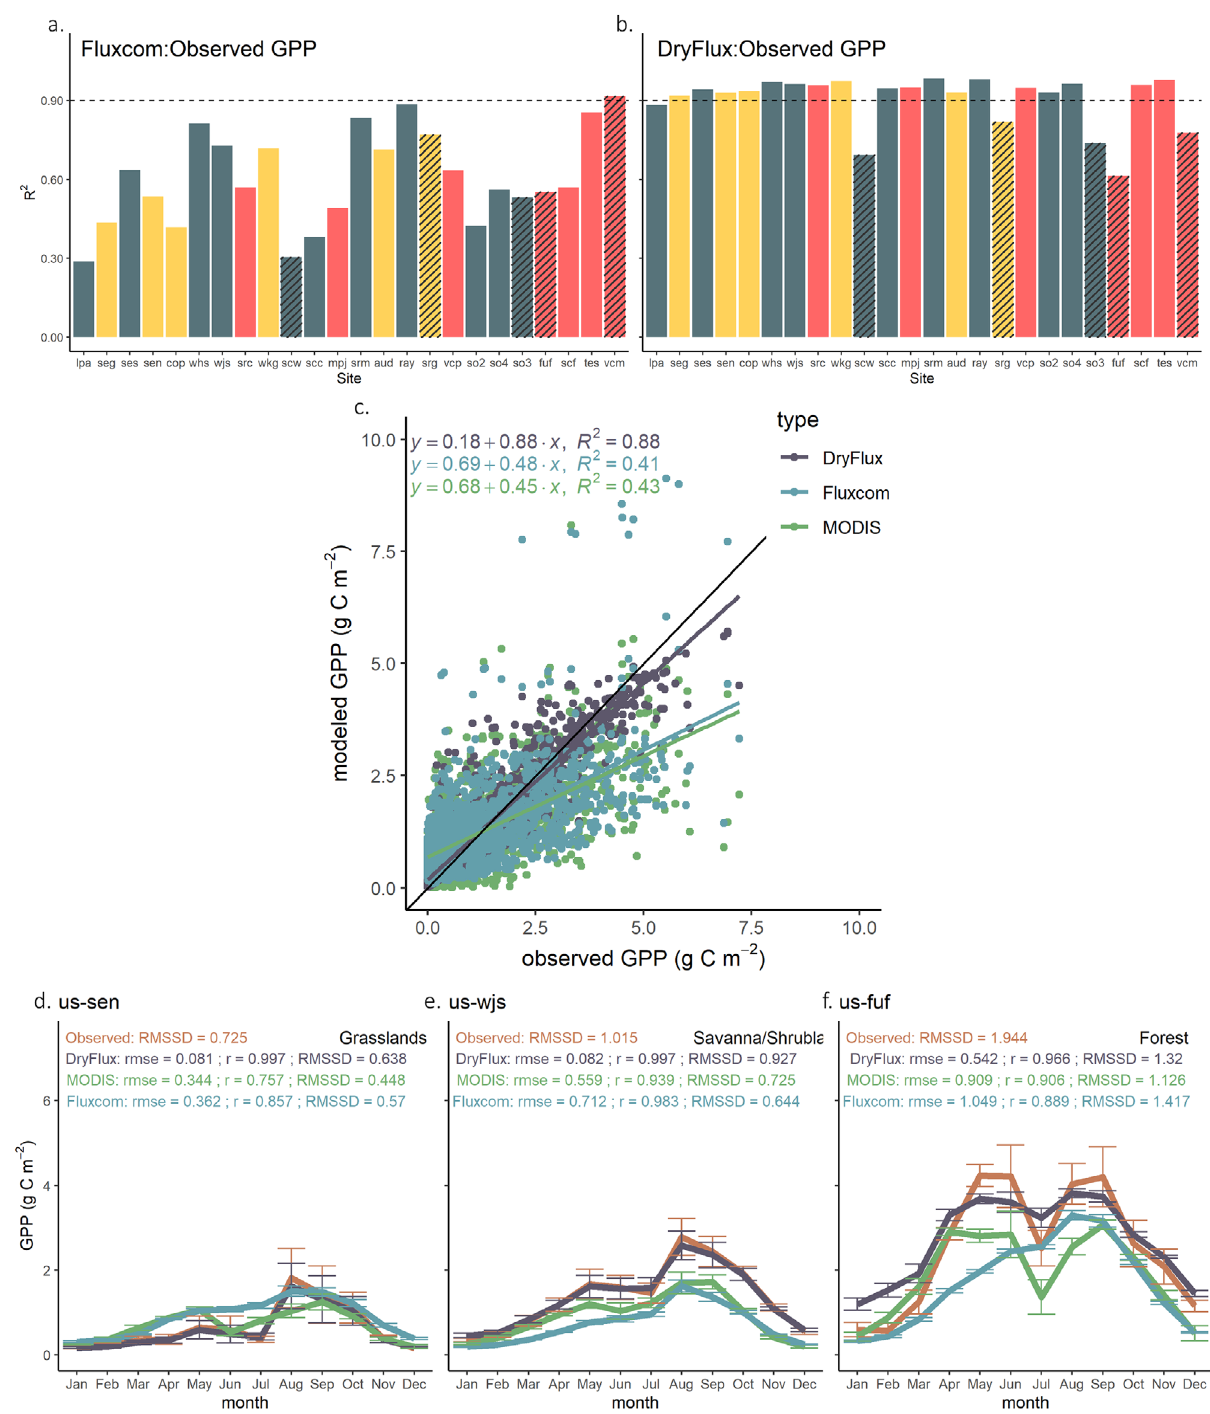
Fig. 1 DryFlux model performance. a Coef fi cient of determination ( R 2 ) between annual FLUXCOM GPP and annual tower GPP (gCm − 2 ) for all fl ux sites. Sites are colored by vegetation class, with diagonal hash mark indicating sites left out of model building (testing sites). The dashed horizontal line indicates an R 2 of 0.9 to facilitate visual comparison of model performance. Sites are arranged according to MAP, with MX-Lpa having the lowest MAP (182 mm) and US-Vcm having the highest (724 mm). b Same as ( a ) but R 2 between annual DryFlux GPP and tower GPP. c Relationships between modeled GPP and observed monthly GPP. Monthly (in gCm − 2 day − 1 ) FLUXCOM GPP (teal), MODIS GPP (green), and DryFlux GPP (dark gray) and the associated linear equations are displayed, with the 1:1 line between modeled and observed GPP in black. d – f Accuracy of DryFlux GPP seasonal cycle compared to observed, MODIS, and FLUXCOM GPP for a representative grassland ( d ), shrubland ( e ), and forest ( f ) site. The seasonal cycle is represented as the average monthly GPP (in gCm − 2 day − 1 ) for all available site years. Lines represent: observed (brown), DryFlux (dark gray), MODIS (green), and FLUXCOM GPP (teal). Error bars represent one standard deviation above and below the monthly mean.